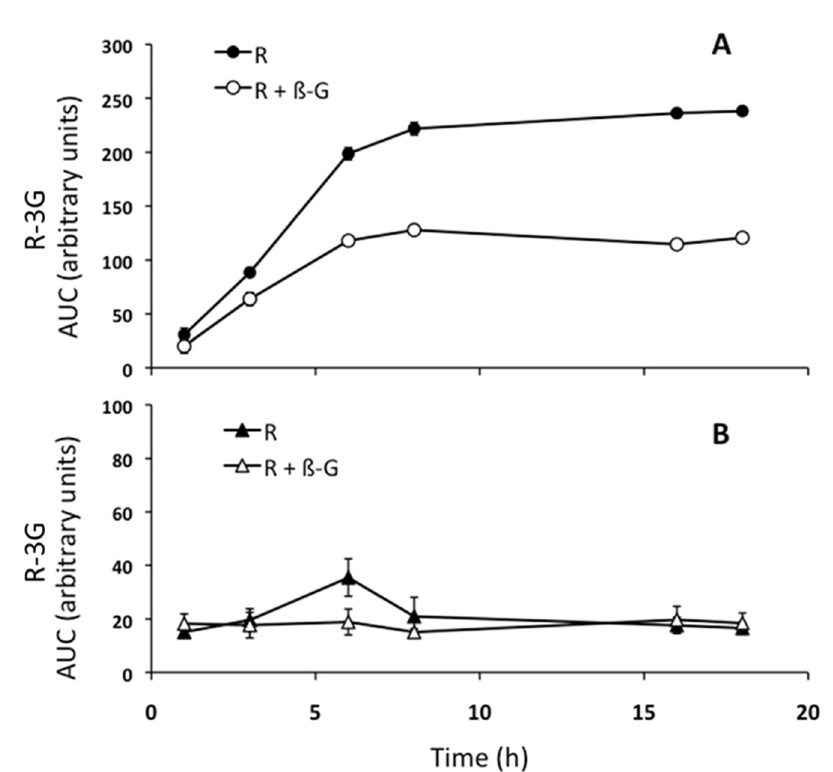
Figure 4. Amount of trans -resveratrol-3- O - β -D-glucuronide (R-3G) in the AML12 hepatocytes incubation media ( A ) and cells ( B ). As shown in the legend, AML12 cells were incubated with PA and resveratrol (25 µM), or with PA and resveratrol + β -glucuronidase (400 U/mL) for 1, 3, 6, 8, 16, and 18 h.